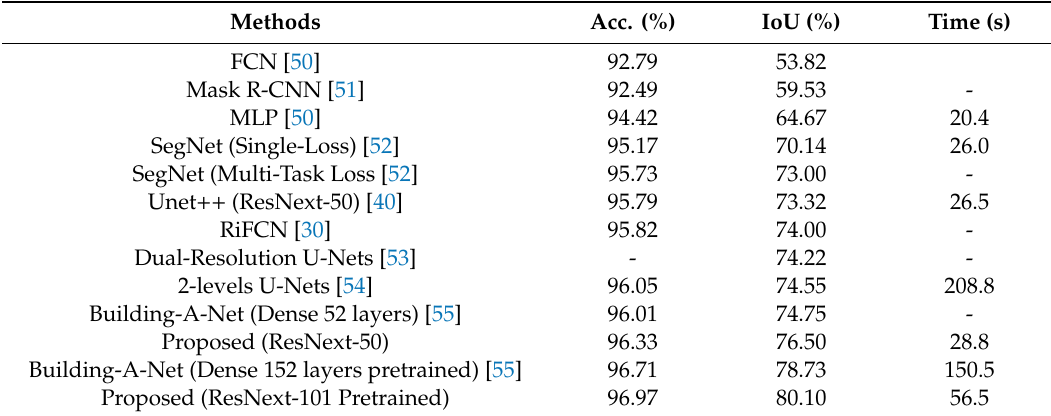
Table 5. Numerical Results of the State-of-the-art models on the Inria